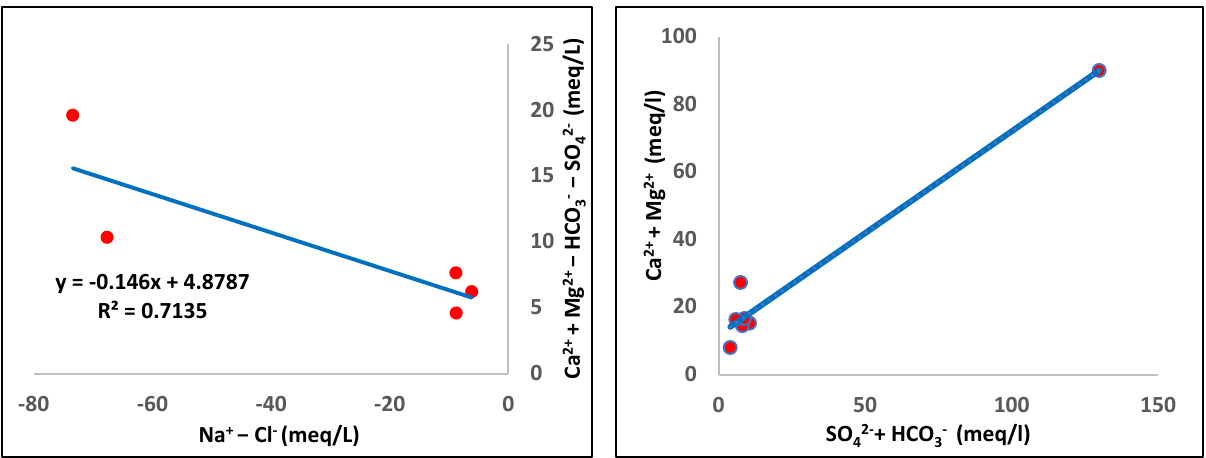
Figure 4. Plot of numerous ions, representing reverse ion exchange of groundwater samples.